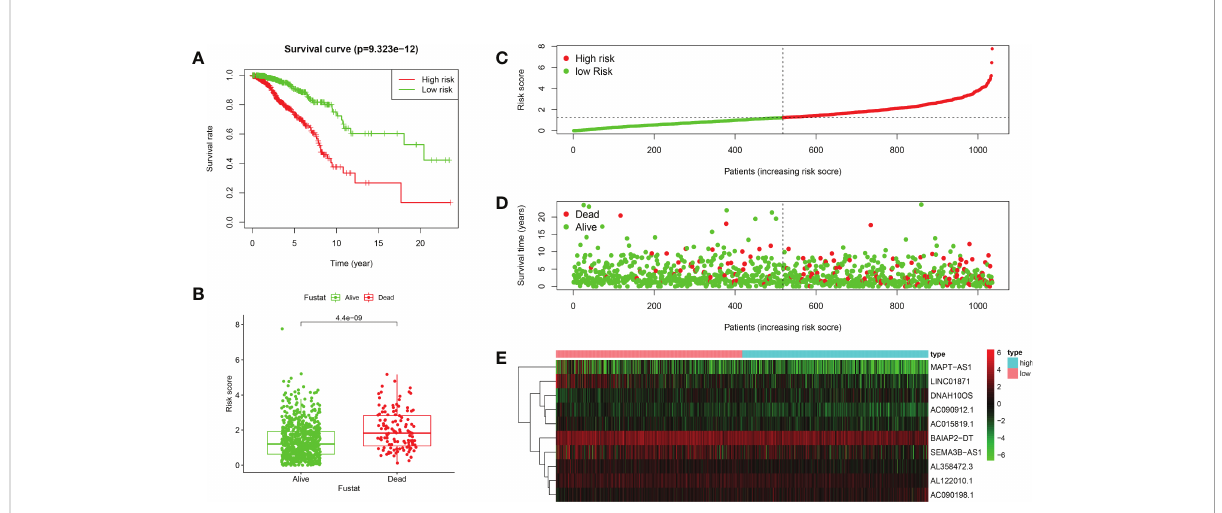
FIGURE 3 Validation of the prognostic value of the ARlncRNA model. (A) Survival curves for the high- and low-risk groups created using Kaplan – Meier survival analysis. (B) A boxplot showing that the risk scores of patients who died were signi fi cantly higher than those of patients who survived. (C) A risk curve based on the risk score of each patient with BRCA. (D) A survival scatter plot based on the survival status of each patient with BRCA. (E) A heatmap showing the expression levels of 10 ARlncRNAs in the low- and high-risk